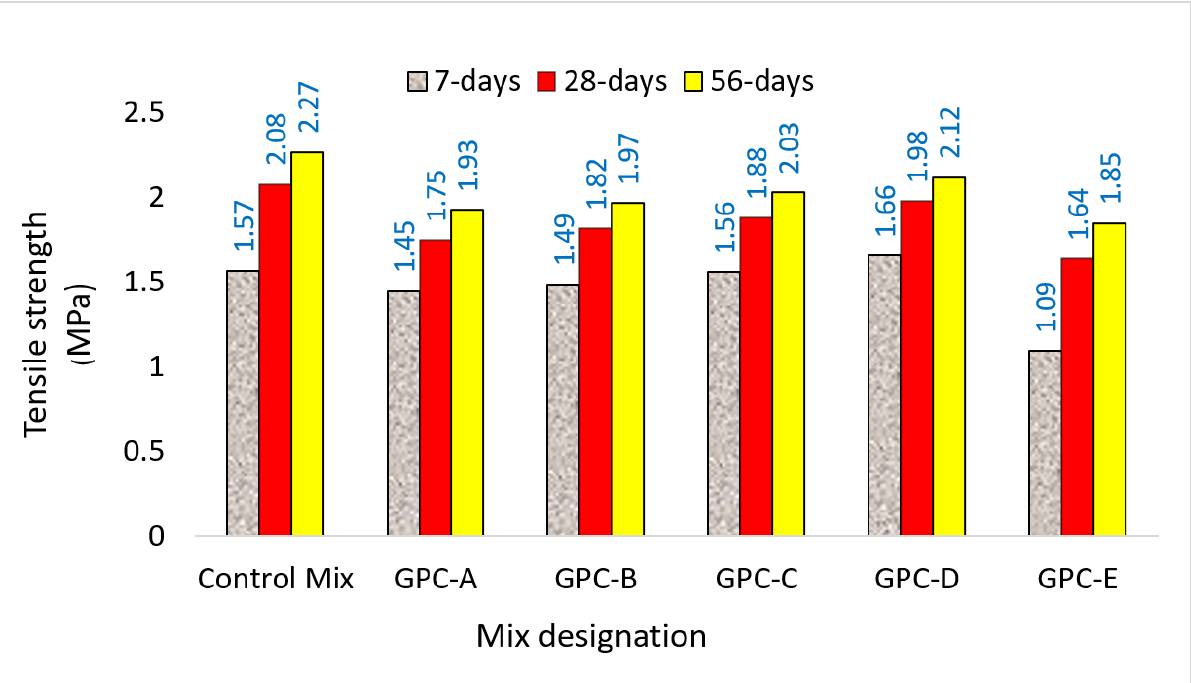
Figure 5. The splitting tensile strength of control OPC and QFS-GPC samples at 7, 28, and 56